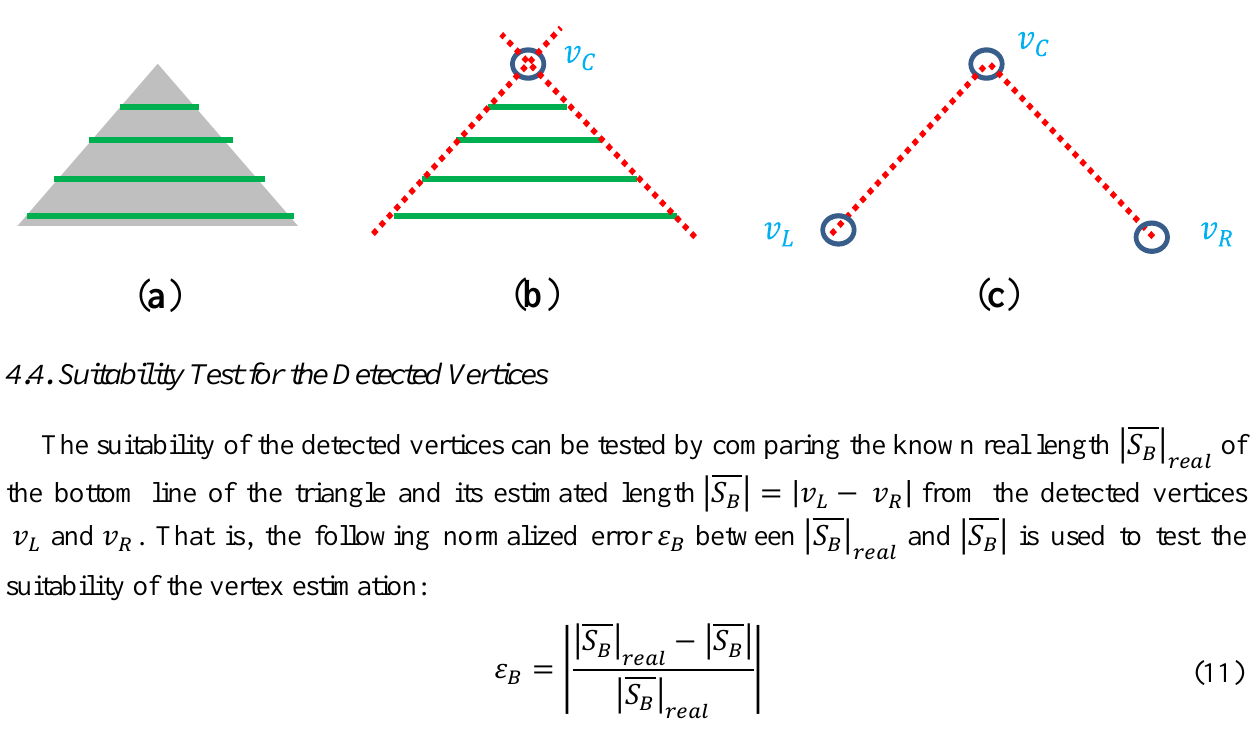
Figure 10. Vertex estimation process for the triangle board: ( a ) Projection of 3D points on the